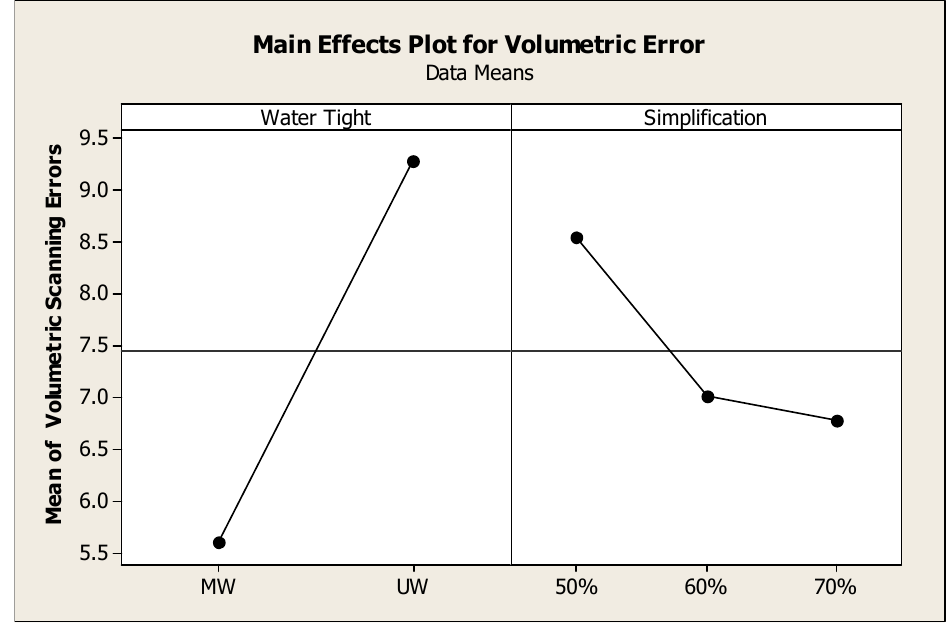
Figure 7. Main effects plot for volumetric error (mode D). Table 4. ANOVA for volumetric error (mode D).